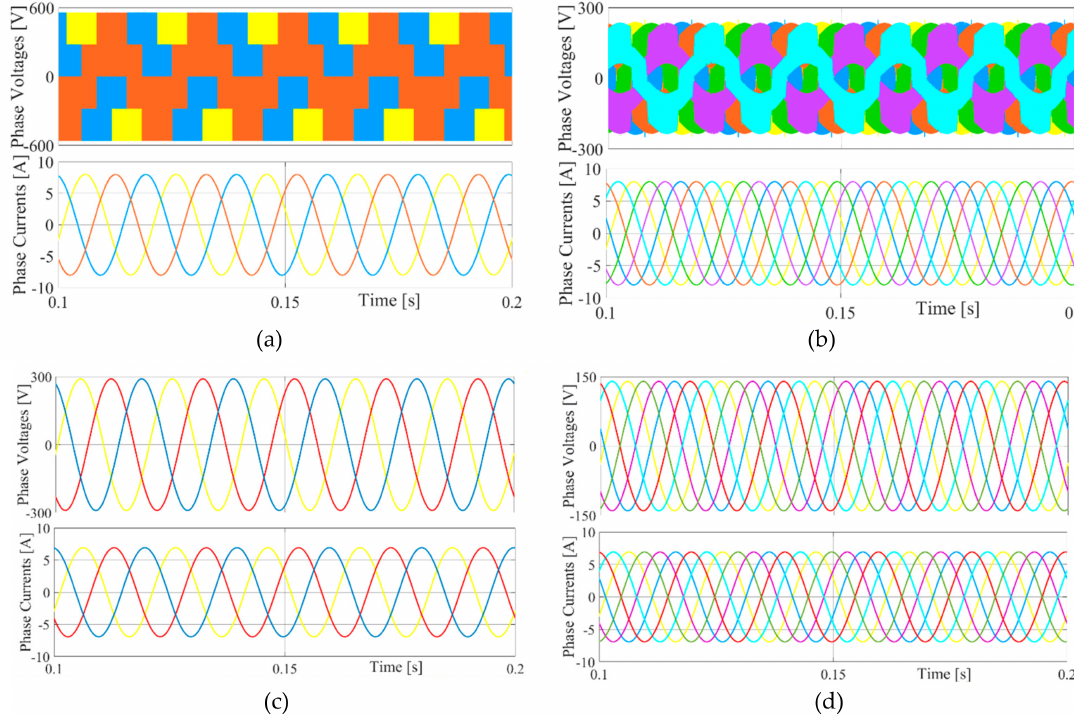
Figure 12. ( a ) Phase voltage [V] and phase current [A] at the primary side (with PWM inverter); ( b ) phase Voltage [V] and Phase current [A] at the secondary side (with PWM inverter); ( c ) phase voltage and phase current at the primary side (with sine ac voltage source); and ( d ) phase Voltage and Phase current at the secondary side (with sine ac voltage